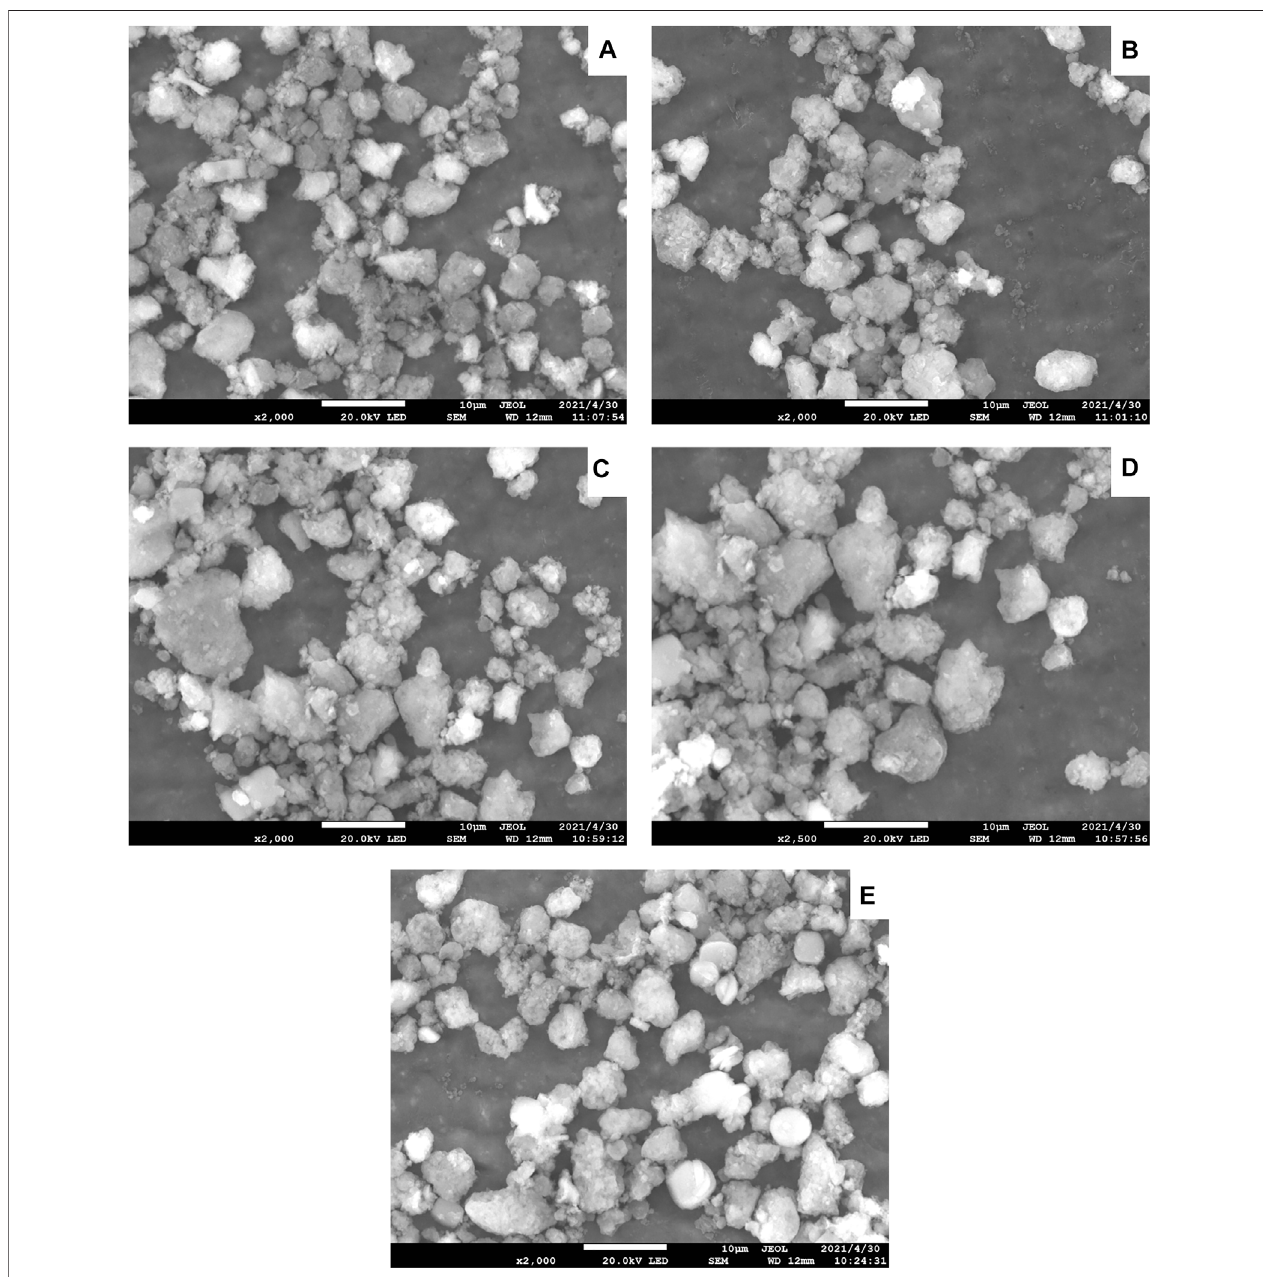
FIGURE2| SEMimagesofNi-modi fi edSAPO-11molecular sieves: (A) 4Ni-SAPO-11, (B) 3Ni-SAPO-11, (C) 2Ni-SAPO-11, (D) 1Ni-SAPO-11,and (E) SAPO-11.